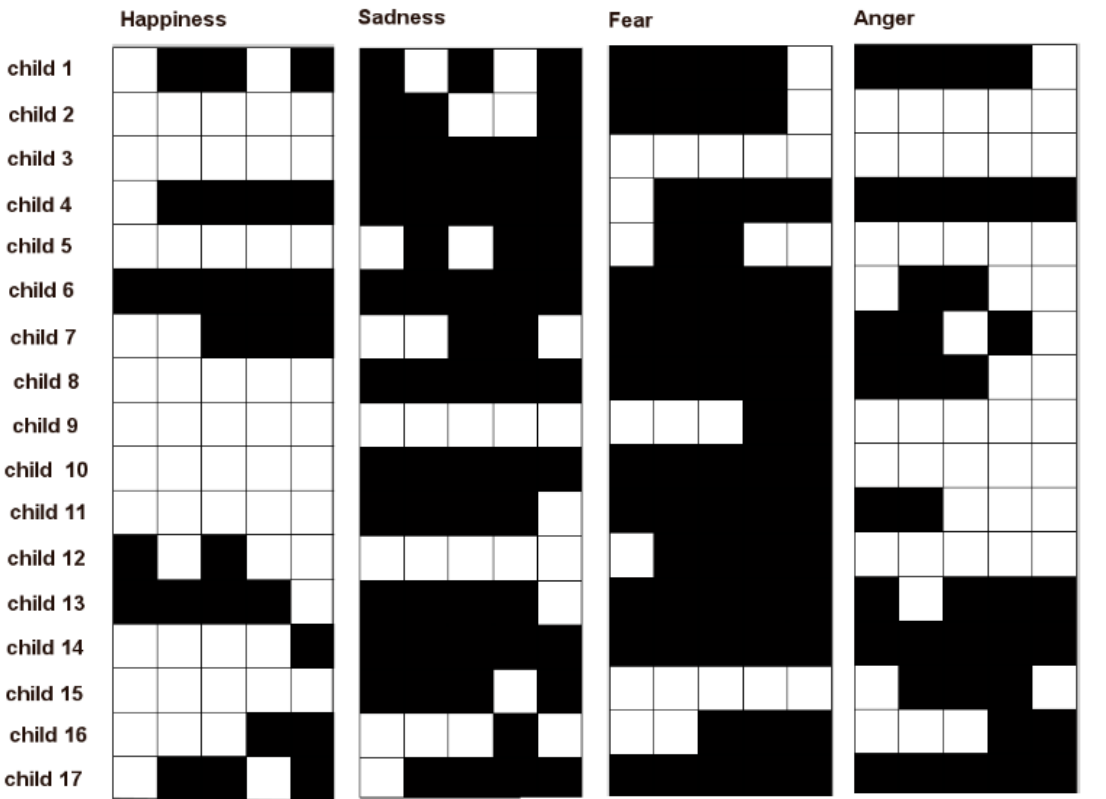
Figure 6. Annotations provided by a group of three expert professionals.